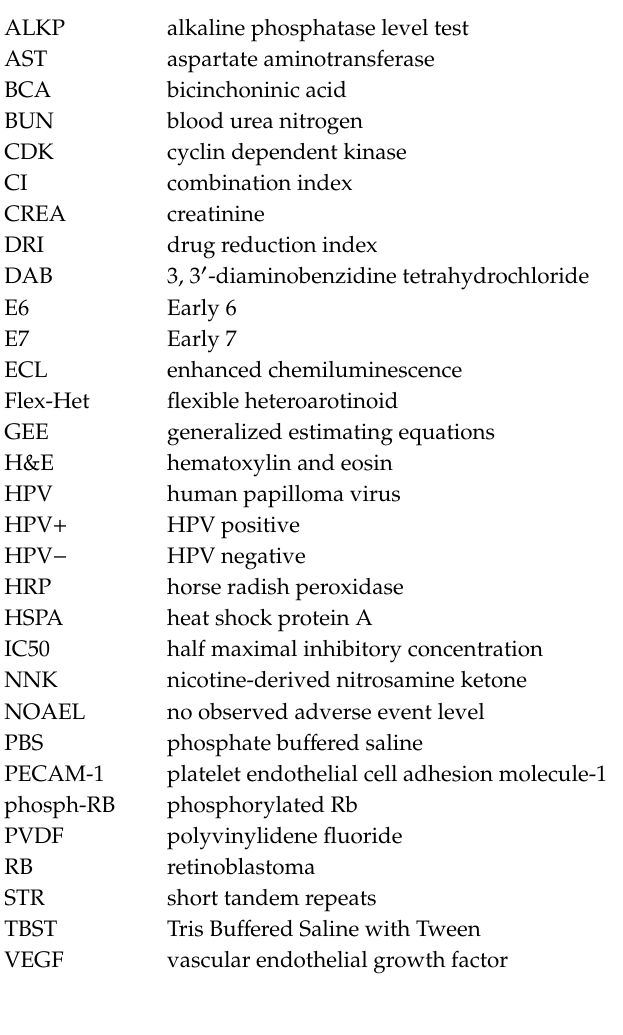
Figure S1. Isobolograms of replicate experiments evaluating SHetA2 and palbociclib Interaction in the C33A, CaSki and SiHa Cell lines, Figure S2: Western blots of SiHa cultures treated with NNK for the indicated amount of time or control solvent for 0.5 h (C) are shown on top, Figure S3: Full Western Blot Images for Figures 2 and